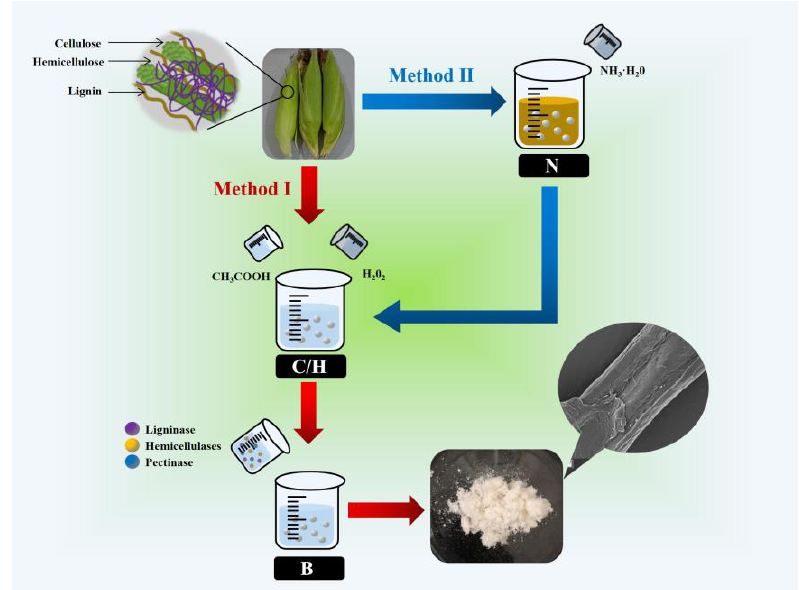
Figure 2. Experimental flow chart (N: NH 3 ·H 2 O; C/H: CH 3 COOH/H 2 O 2 ; B: Bio-enzyme).